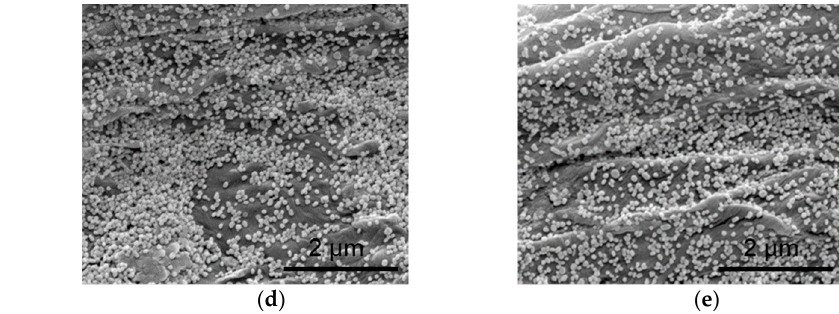
Figure 4. Optimum conditions for substrate preparation by centrifugation. ( a ) SERS spectra of CV (10 − 5 M) obtained from the Au-TPP substrates prepared under different conditions; ( b ) influence of the different drying methods on the peak intensities of 1171 cm − 1 ; ( c – e ) SEM images: ( c ) blank tobacco packaging paper, Au-TPP substrate prepared by ( d ) Cond 2 and ( e ) Cond 5. Note: Cond 1 (2 mL): single centrifugation with 2 mL, drying at 105 ◦ C; Cond 2 (4 mL): centrifugation with 2 mL, two times, 105 ◦ C; Cond 3 (6 mL): centrifugation with 2 mL, three times, 105 ◦ C; Cond 4 (2 mL): single centrifugation with 2 mL, vacuum freeze-drying; Cond 5 (4 mL): centrifugation with 2 mL, two times, vacuum freeze-drying; Cond 6 (6 mL): centrifugation with 2 mL, three times, vacuum freeze-drying.